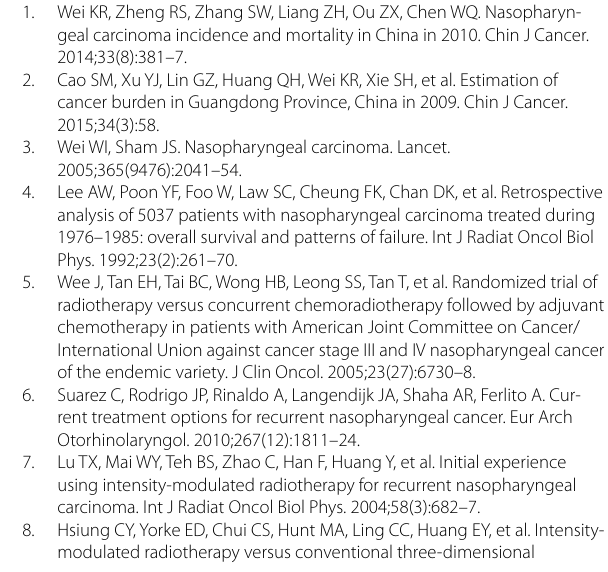
Logitπ was calculated from the model and classified into four degrees according to the corresponding risk of developing LNN LNN lethal nasopharyngeal